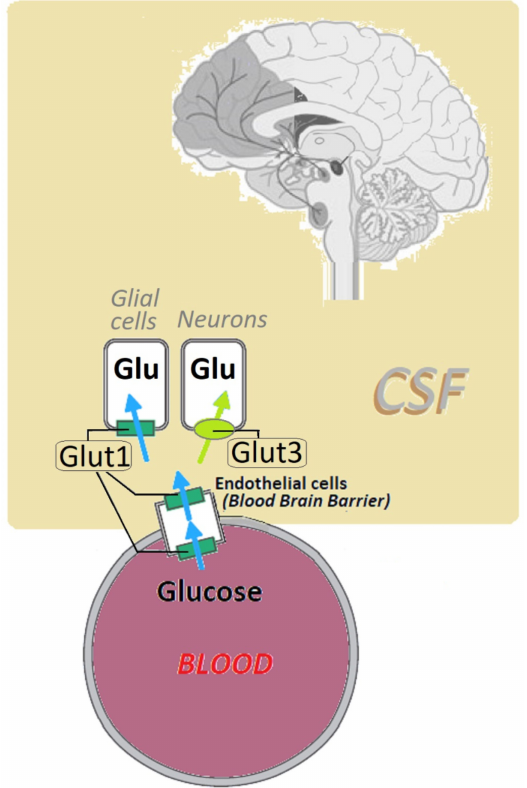
Figure 1. Representation of the main glucose transporters into the brain, Glut1 and Glut3, belonging to facilitated, “passive” transporters (encoded by members of the SLC2 gene family). Transport across cell membranes is depicted by arrows; localization and known defects of Glut1 are shown by green rectangular symbols (based on [12,15]). Legend: Glu, glucose; CSF, cerebrospinal